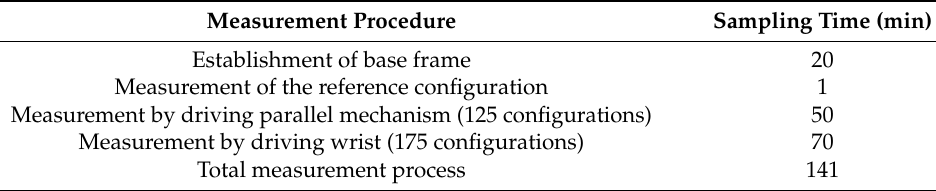
Figure 8. Distribution diagram of the TCP in the robot workspace: ( a ) Sampling configurations of W1; ( b ) Sampling configurations of W2; and ( c ) Configurations through composition. Table 2. Sampling time of the proposed method.